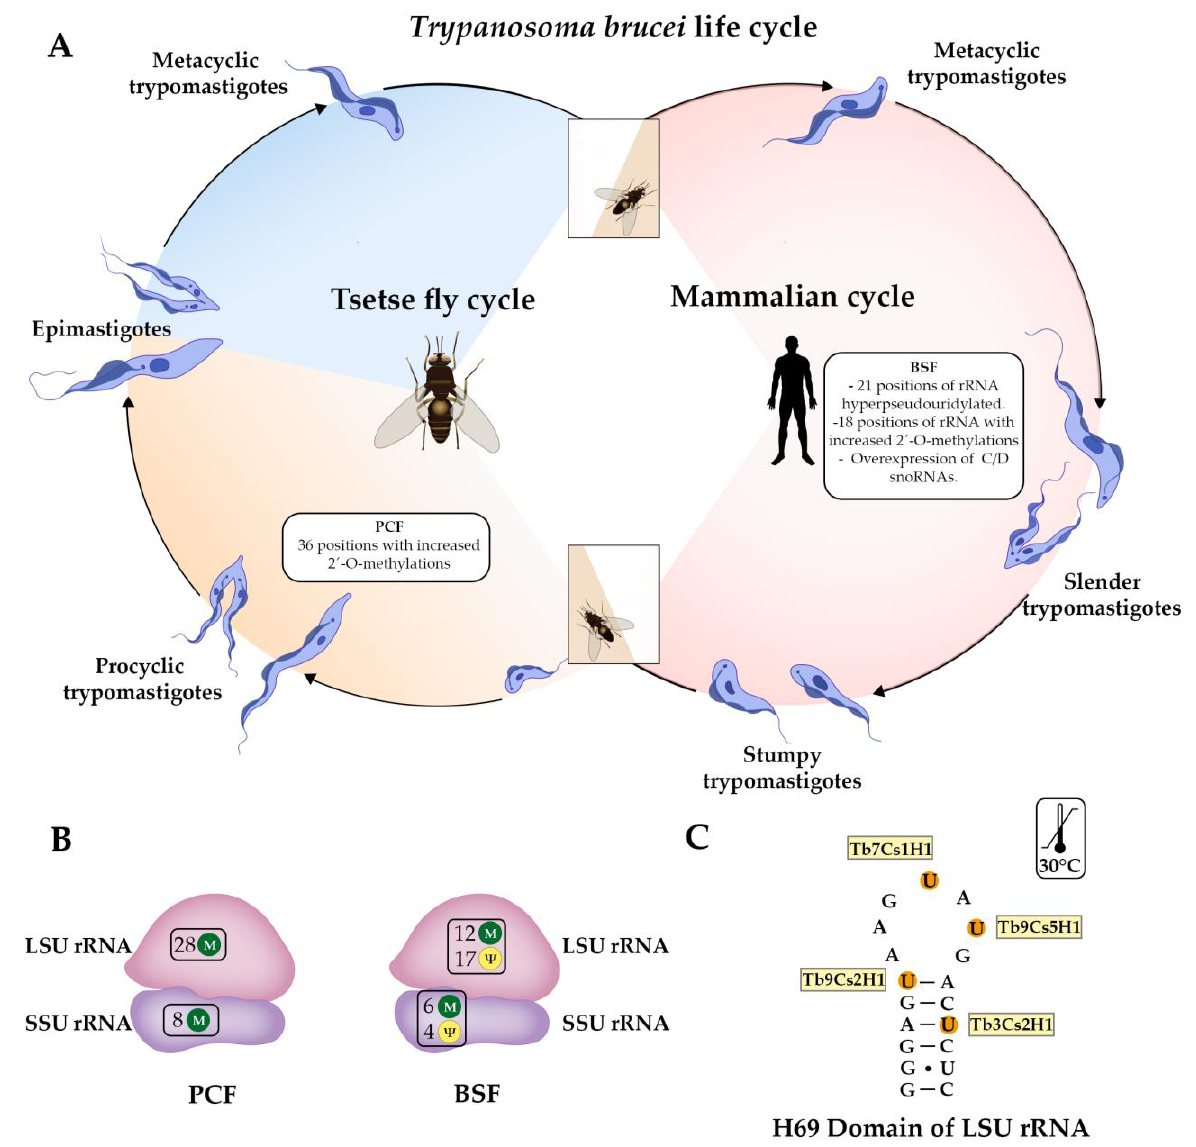
Figure 3. rRNA modifications observed in different stages of the Trypanosoma brucei life cycle. ( A ) Bloodstream forms (BSF), mainly represented by slender replicative trypomastigotes in the blood of the mammalian host, show 21 hyper-pseudouridylated ( Ψ ) positions in rRNA, many of them in domains located in the peptidyl-transferase center (PTC), as well as 18 positions with 2 ′ -O-methylations increased, which is accompanied by the overexpression of most of C/D snoRNAs. Procyclic forms (PCF), also known as procyclic trypomastigotes, display an increase in 2 ′ -O-methylations in 36 positions of rRNA compared with BSF. ( B ) Number of 2 ′ -O-methylations (green circles with an M) and pseudouridylations (yellow circles with Ψ) in the large subunit (LSU) and the small subunit (SSU) of the ribosome in BSF and PCF. ( C ) Hypermodified positions in Helix 69 (H69) of LSU rRNA. The H/ACA snoRNAs involved in the pseudouridylation of ribosomal RNA are highlighted in yellow boxes. Overexpression of these snoRNAs in PCF favors the acceleration of their growth at 30 °C. Another layer of translational control is achieved by ribosome-associated